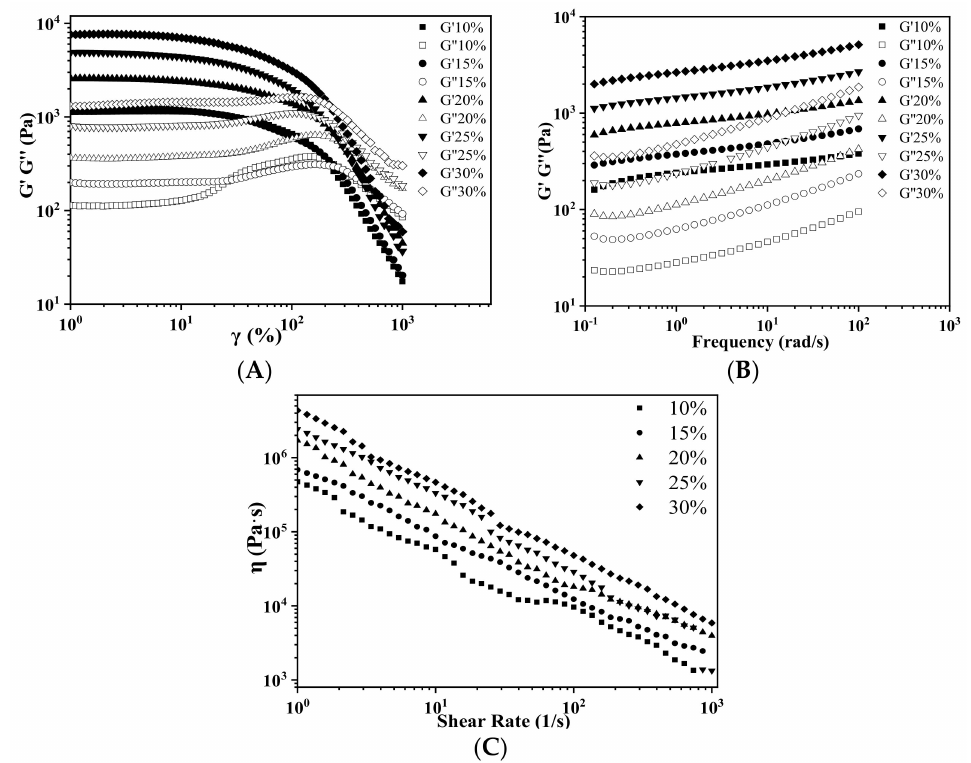
Figure 5. ( A ) Plots of storage modulus (G (cid:48) ) and loss modulus (G (cid:48)(cid:48) ) versus strain for arrowroot starches of different concentrations; ( B ) plots of storage modulus (G (cid:48) ) and loss modulus (G (cid:48)(cid:48) ) versus angular frequency for arrowroot starches of different concentrations; and ( C ) plots of apparent viscosity versus shear rate for arrowroot starches of different